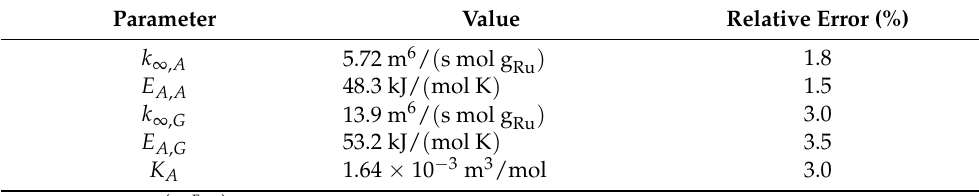
Table 1. Kinetic parameters of the rate expressions to describe the 41 experimental concentration-time plots for single sugar hydrogenation [43] as well as sugar mixture hydrogenation